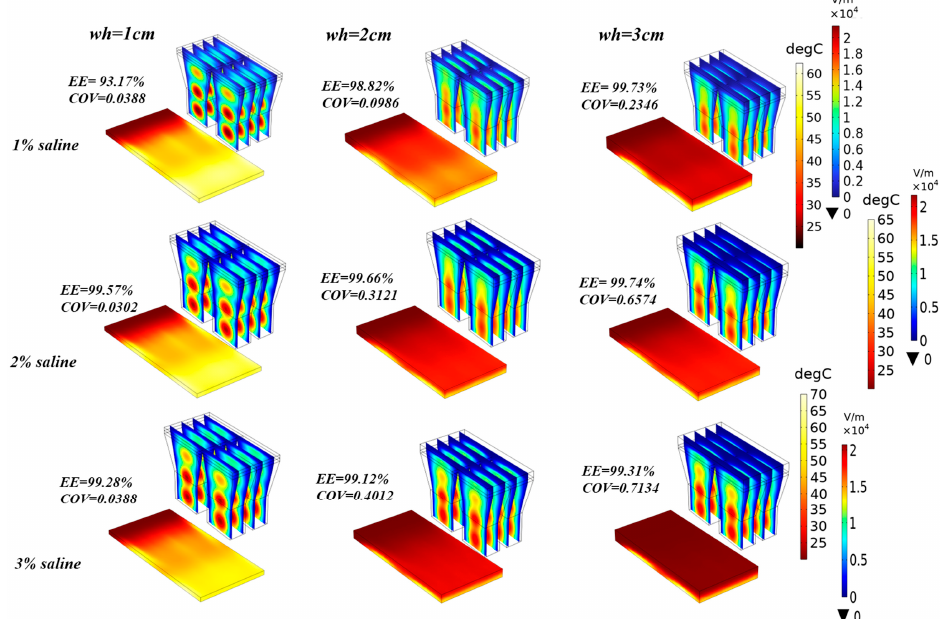
Figure 8. Effect of different concentrations and heights of saline water on electric field distribution and temperature uniformity (‘wh’ represents the liquid thickness).